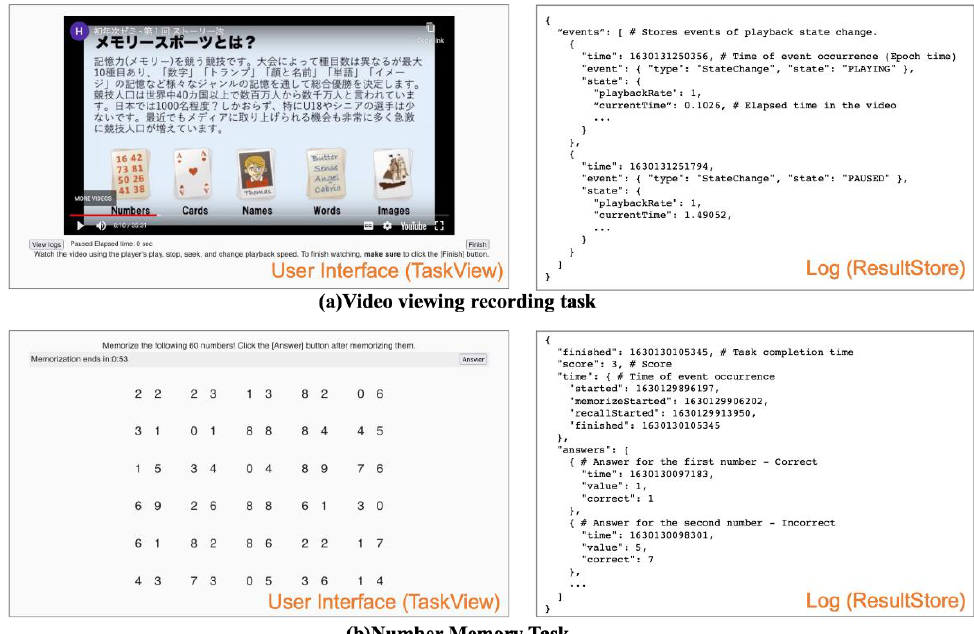
Figure 3. Screenshot of the execution of sample tasks: For the case study, we prepared two tasks: ( a ) a video viewing task and ( b ) a number memory task. Task ( a ) is a lecture video on the theme of memory techniques, and the subject’s viewing behavior, such as playing, stopping, and changing the playback speed, is recorded with a timestamp; ( b ) is a task to memorize and repeat 60-digit numbers within a specific timeframe. The number sequence to be memorized is randomly generated, and the content of the answer, identification of an answer as correct or incorrect, and the timing of the answer are recorded together with a timestamp.